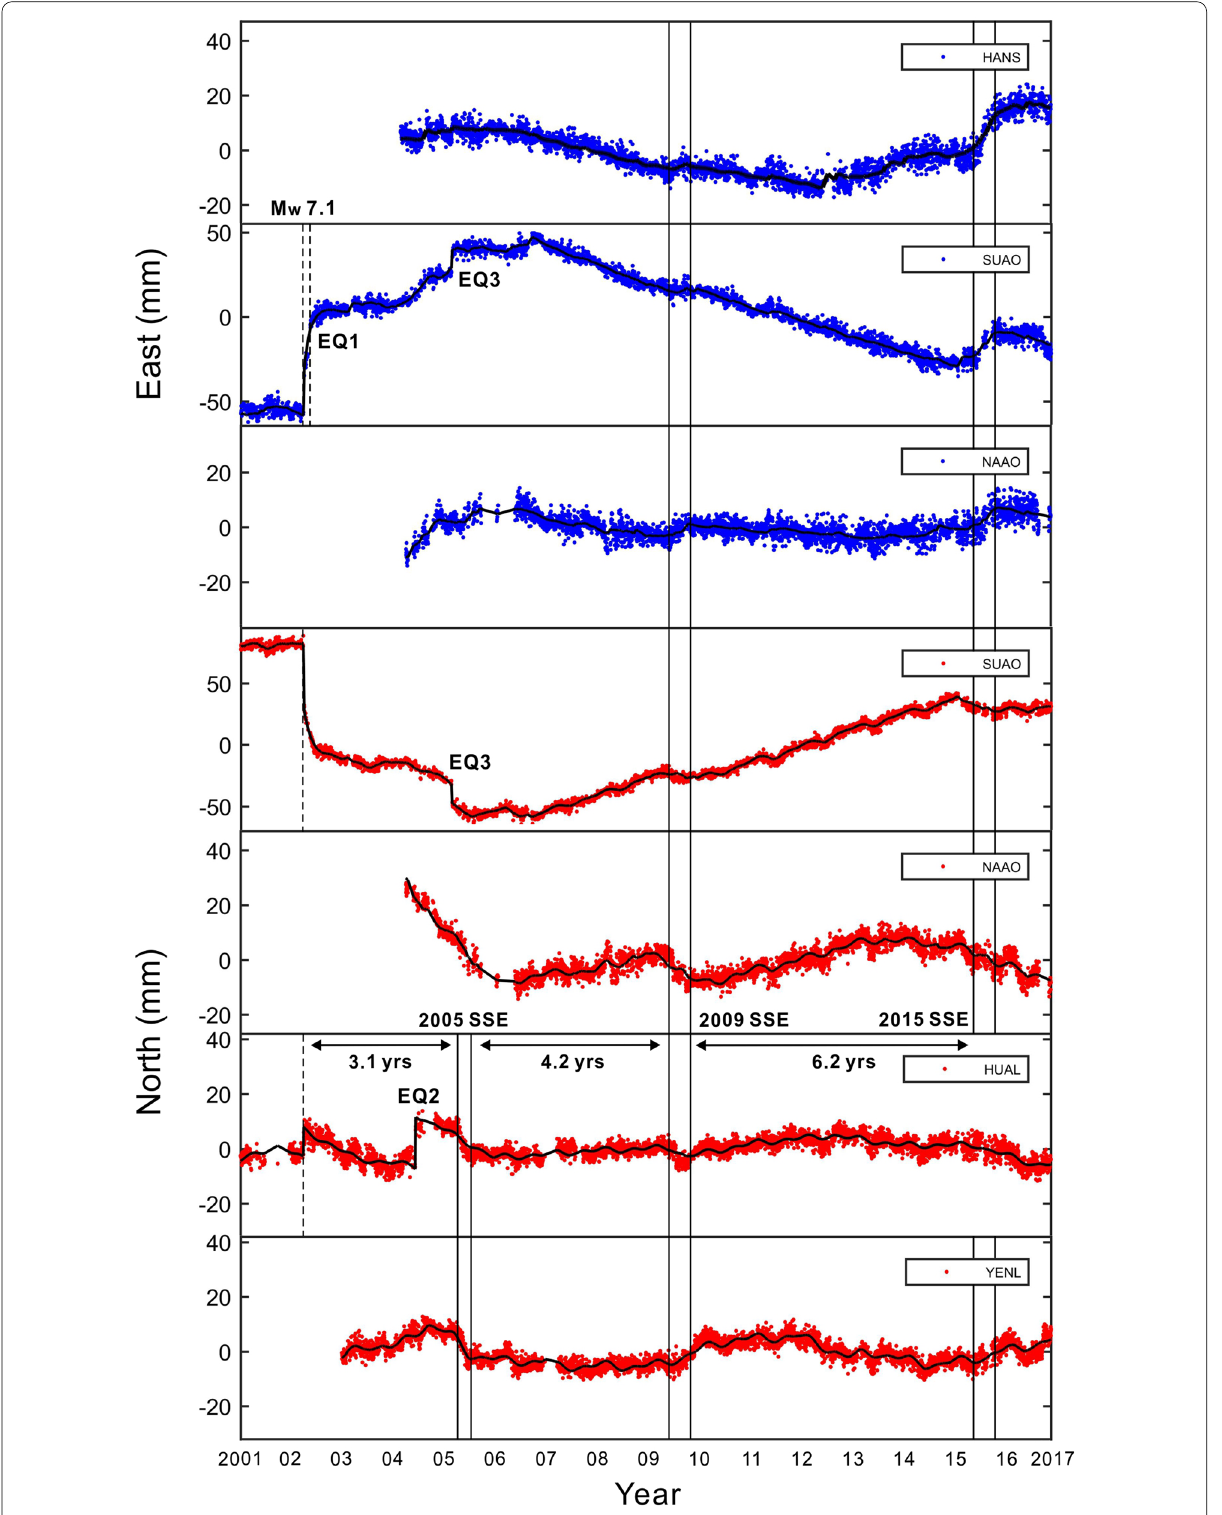
Fig. 2 (See legend on previous